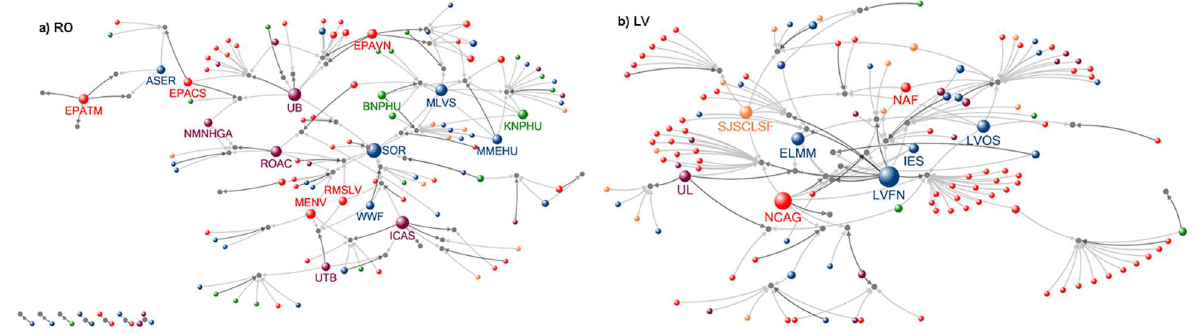
Fig 2. LIFE Nature partnership network for Romania and Latvia (size of nodes for organisation = degree; circles: red—public authority, blue–NGO, green—park reserveauthority, purple—researchand education, orange–enterprises, grey–project; dark grey arrow—link to a beneficiary, grey arrow—link to a partner; isolated projects are presented in the left bottom of a network; abbreviations are shown in S4 Table).